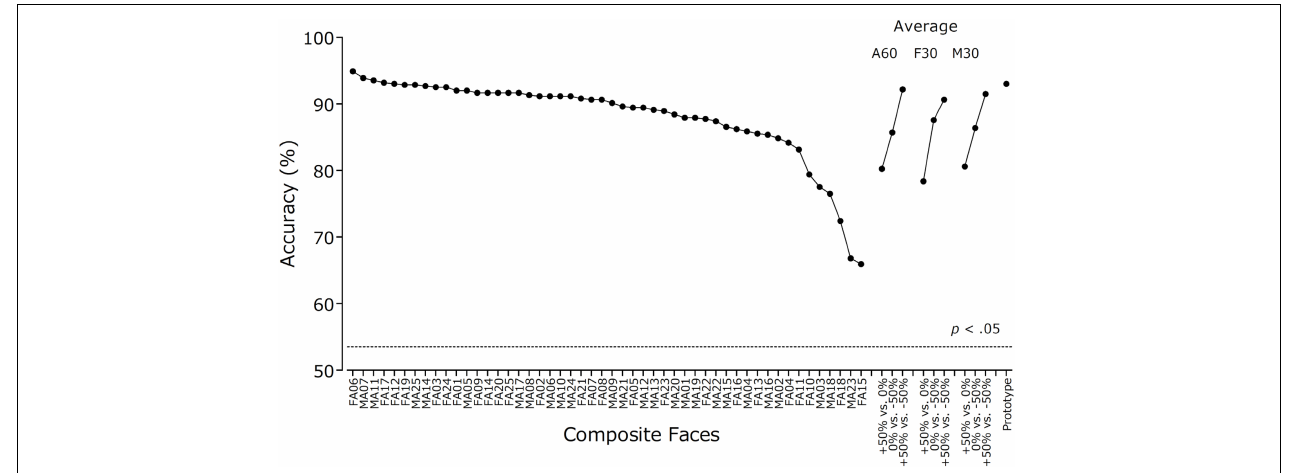
FIGURE 3 | Discrimination accuracy for manipulated high- vs. low-cuteness versions of 50 composite faces and three types of average faces ( N = 587). Accuracy for prototypical high- vs. low-cuteness faces is also shown. The dotted line shows the threshold of statistical significance computed from the binomial distribution.